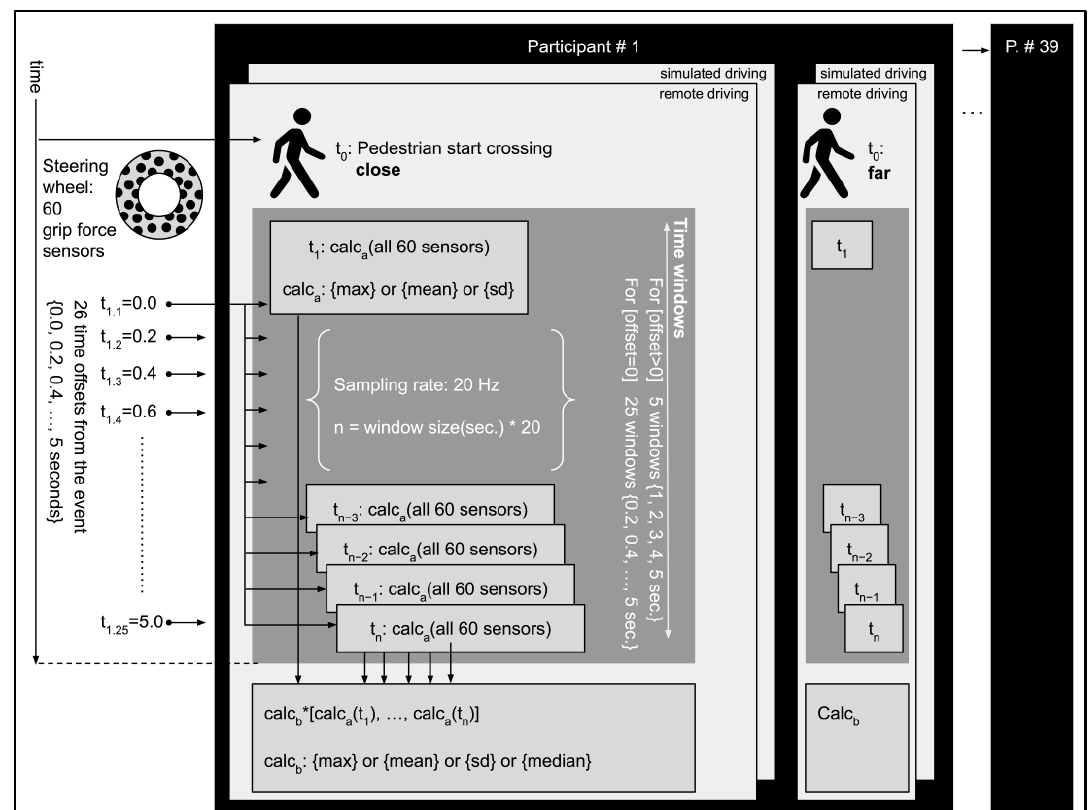
Figure 6. Grip force data collection and calculations. As illustrated, for each participant and each pedestrian crossing event, grip force data were calculated (Calc a : maximum, mean, or standard